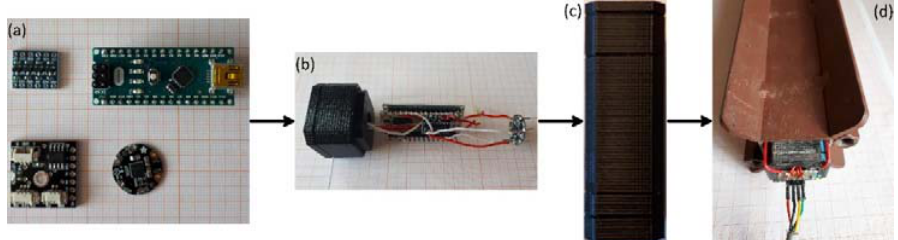
Figure 5. Diagram showing components and assemblage phases of the inclinometer modules. Figure5. Diagramshowingcomponentsandassemblagephasesoftheinclinometermodules. Especially, ( a ) shows the electronic components used; ( b ) shows the first assembly phase of the electronic components in the Acrylonitrile Butadiene Styrene (ABS) frame; ( c ) shows the appearance of the measuring unit composed by electronic components within the plastic housing; and ( d ) shows how a measuring unit is installed within the external steel